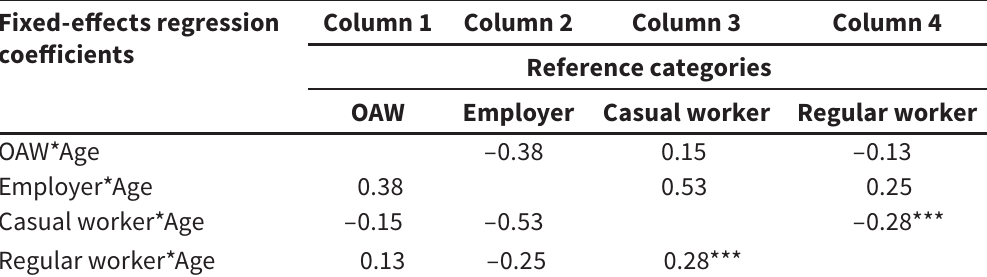
Fixed-effects regression coefficients for the interaction between sectoral choice and age